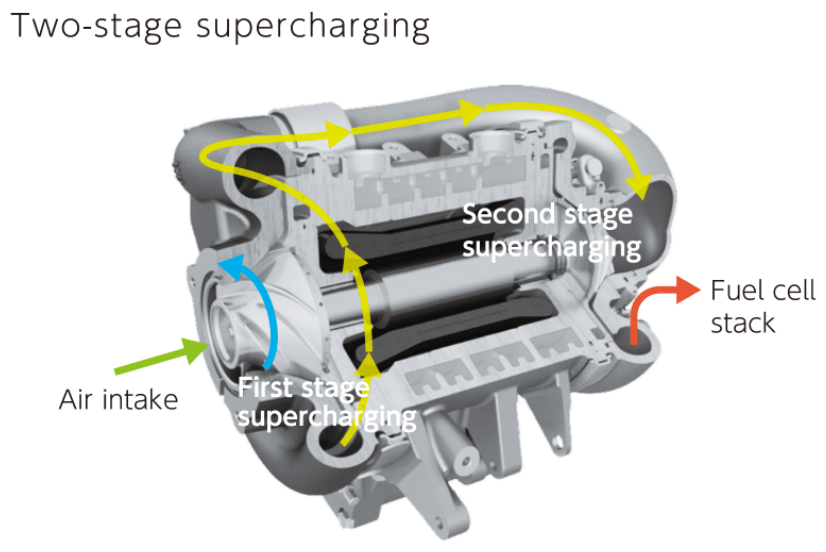
Figure A1. Two-stage compressor used in the Honda Clarity Fuel Figure A1. two-stage compressor used in the Honda Clarity Fuel Cell.